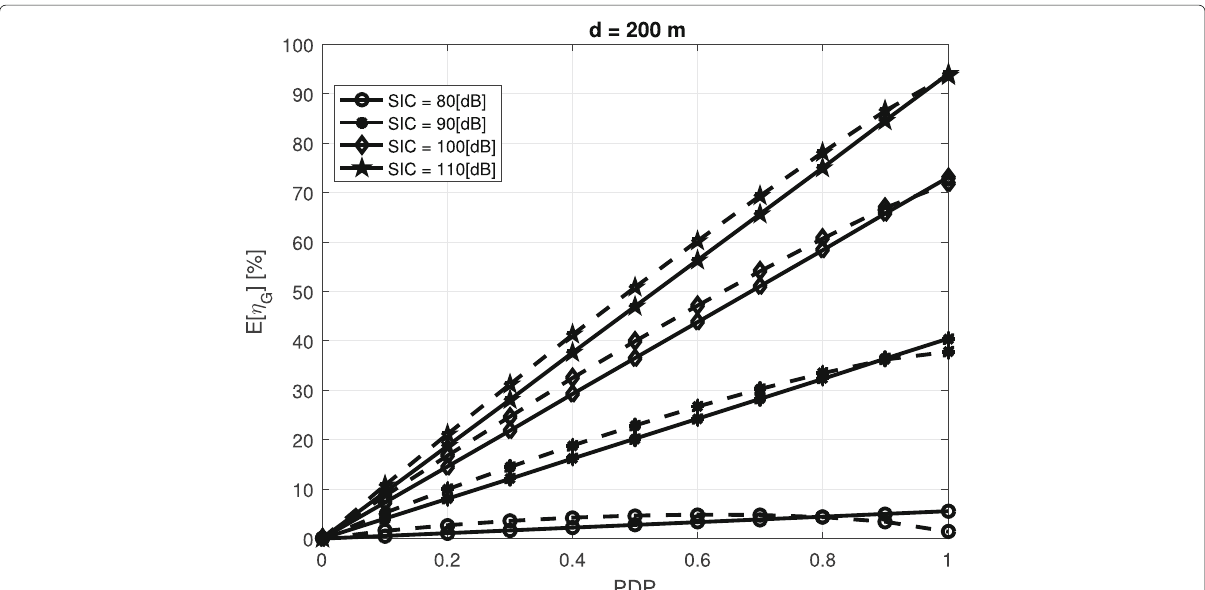
Fig. 4 PD spectral efficiency gain in AWGN and in frequency selective fading channel. Spectral efficiency gain E [ η G ][%] vs. the parameter PDP for different values of SIC and link distance d = 200 m; continuous lines refer to AWGN channel and dashed lines to Rayleigh channel with frequency selectivity λ C = 0.001 and the SPD